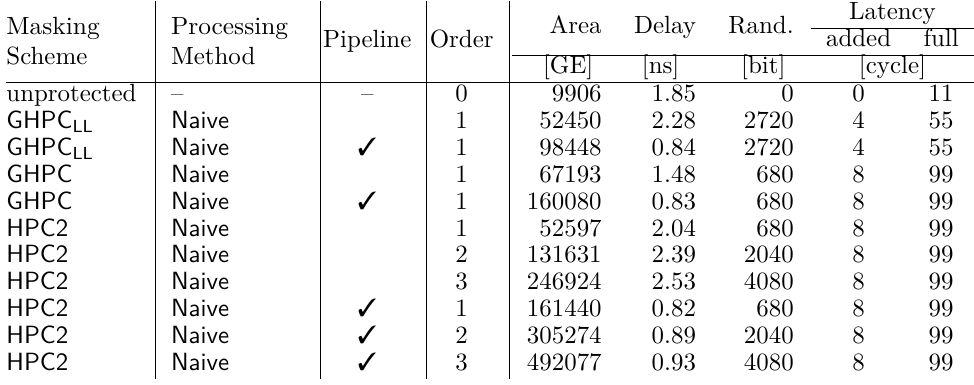
Table 9: Synthesis results, AES round-based encryption